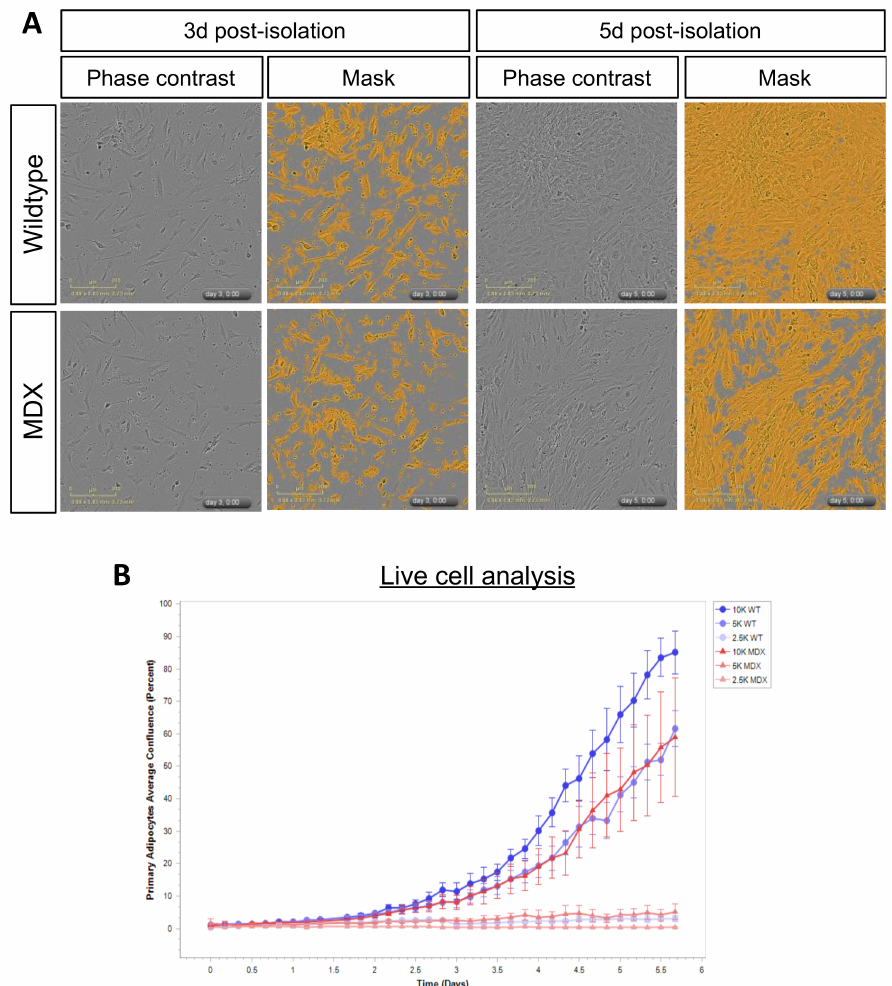
Figure 4. Primary adipose progenitor cells (APCs) from MDX mice exhibit in vitro expansion defects. ( A ) Representative images of APC cultures derived from WT and MDX mice at 3d and 5d post-isolation. Shown are phase contrast images and corresponding mask overlays used for proliferation quantification analyses. ( B ) Line graphs depicting proliferation curves of WT (blue curves) and MDX (red curves) APCs over a 5d time-course. Shown are proliferation curves based on initial seeding densities of 2.5 K (light coloring), 5 K (medium coloring), and 10 K (dark coloring) APCs/well of a 96-well